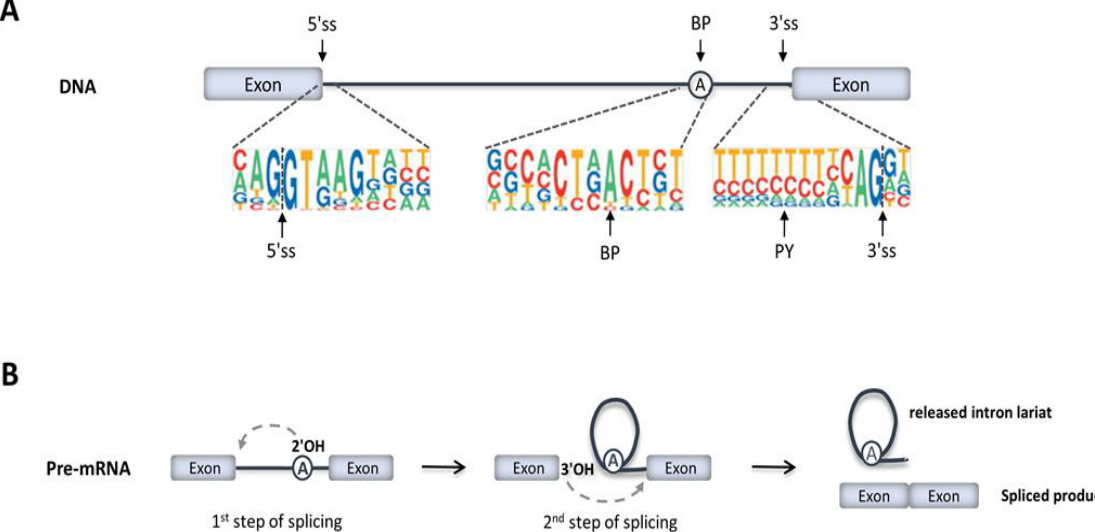
Figure 1. Precursor messenger RNA (pre-mRNA) splicing. ( A ) Exons are represented by boxes and introns by lines. The most conserved nucleotides at the 5’ splice site (5’ss), branch point (BP), polypyrimidine tract (PY), and 3’ splice site (3’ss) are indicated. ( B ) The two transesterification reactions that result in the excision of introns from pre-mRNA are represented.